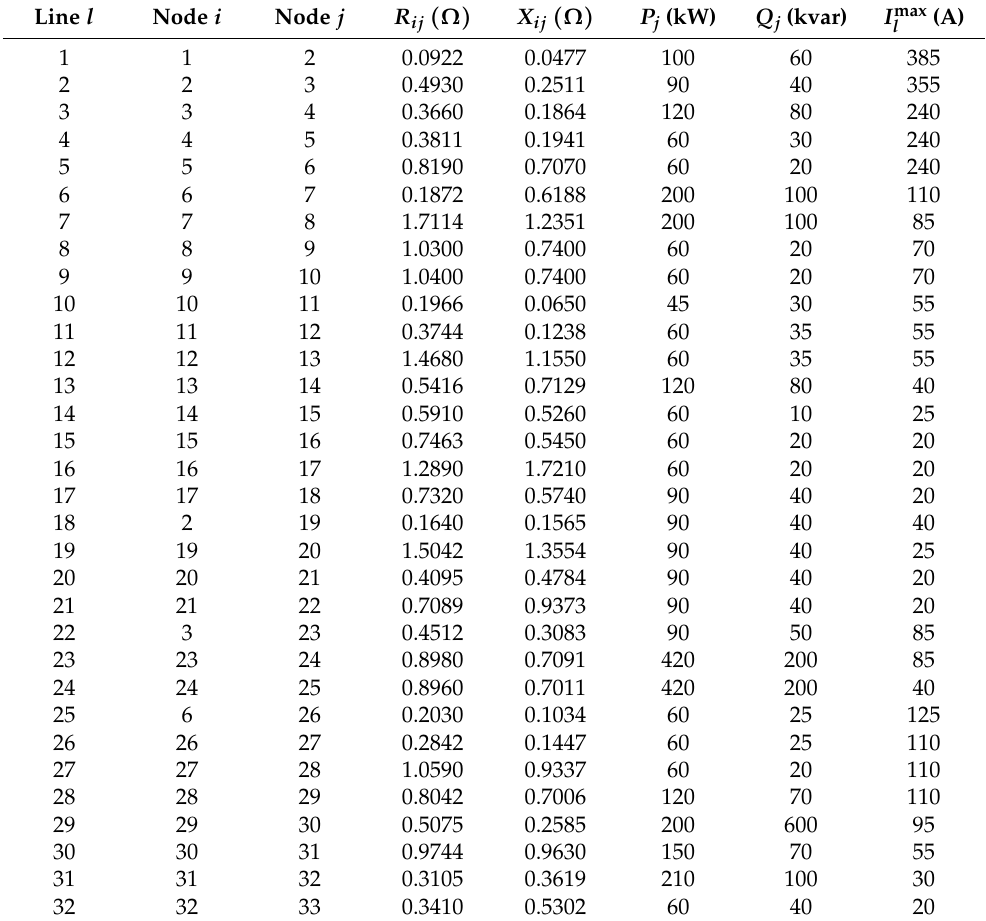
Table 5. Information regarding the peak load conditions, impedance parameters, and current bounds of the IEEE 33-bus